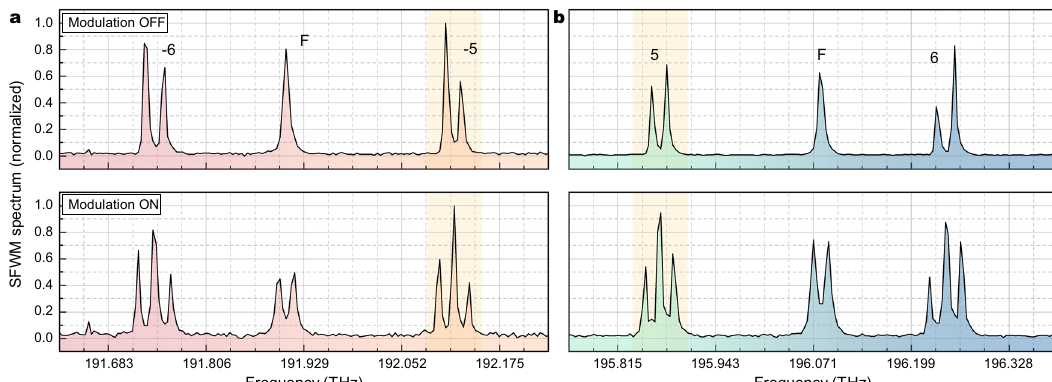
Fig. 3 | Effect of modulation on spontaneous four-wave mixing spectra. Nor- malizedspontaneousfour-wavemixingspectraforthe a idlerand b signalchannels after demultiplexing both in the absence (upper panels) and presence (lower panels)ofmodulation.Thebinpairorder m withrespecttothepumpresonancesis marked,whilespontaneousfour-wavemixinggeneratedintheadd-drop fi lterrings is marked as F. Note that, despite the different out-coupling ef fi ciency for each resonance and the limited resolution of the spectrometer, it is still possible to